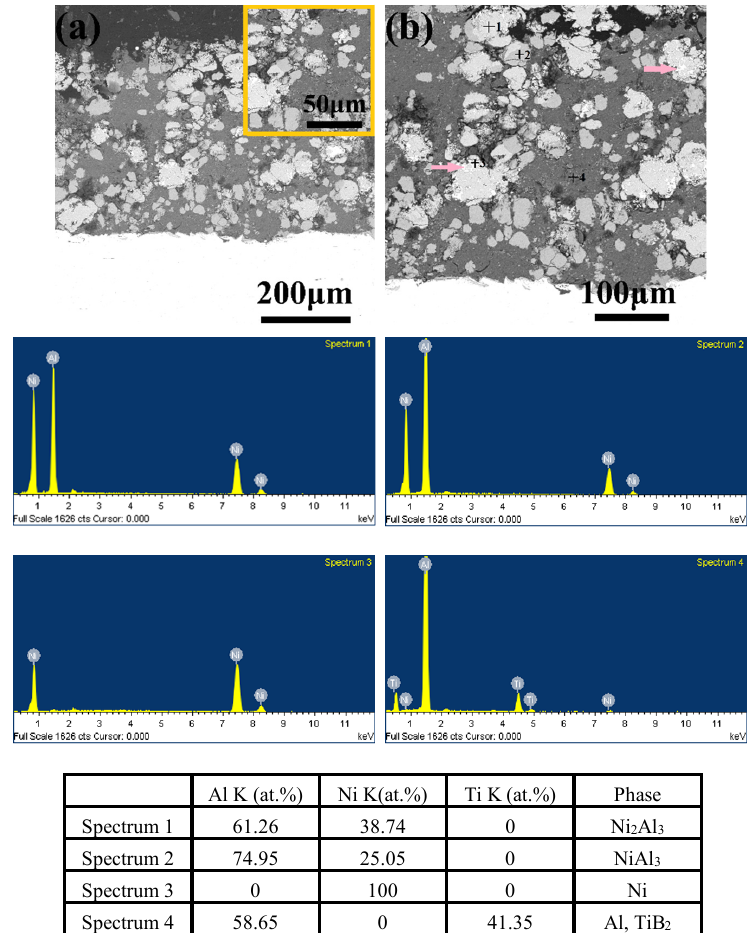
Figure 10. Cross-sectional morphologies and compositions of Ni / Al-TiB 2 coatings as-sprayed at 250 ◦ C and after annealing at 650 ◦ C for 10 h: ( a ) 200 × , and ( b ) 500 × .